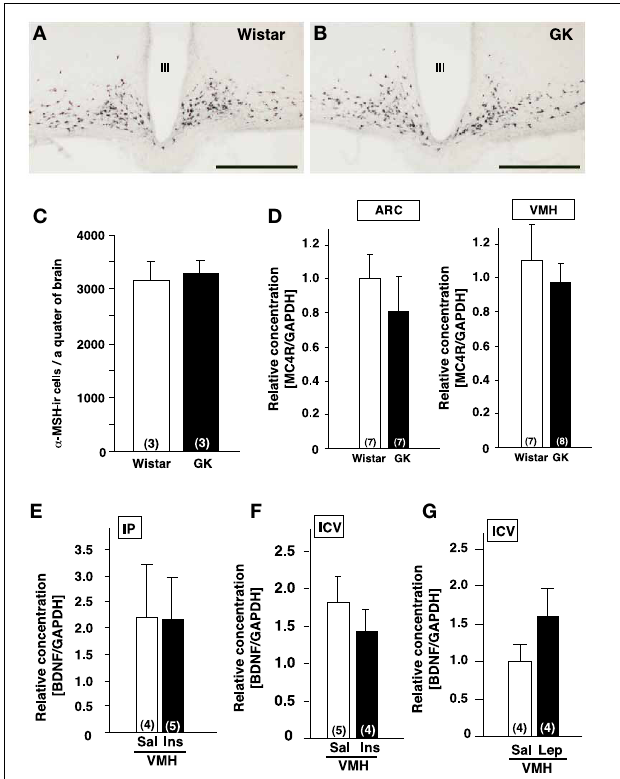
FIGURE 2 | Lack of alterations of melanocortines and effects of insulin and leptin on BDNF mRNA expression in GK rats. (A,B) Representative images of α -MSH-immunoreactive neurons in ARC of Wistar (A) and GK (B) rats. III; the third ventricle, Scale bar = 500 μ m. (C) Numbers of α -MSH-immunoreactive neurons in Wistar and GK rats. (D) MC4R mRNA expressions in ARC and VMH were not different between Wistar and GK rats. (E) Repeated intraperitoneal injection of insulin (1U/kg body weight, twice a day for 3 days) in GK rats did not alter BDNF mRNA level in VMH. (F) Single icv injection of insulin (10mU) in Wistar rats did not alter BDNF mRNA levels in VMH. (G) Repeated icv injection of leptin (5 μ g, twice a day for 3 days) to the fasting Wistar rats had no significant effect on BDNF mRNA levels in VMH of Wistar rats.